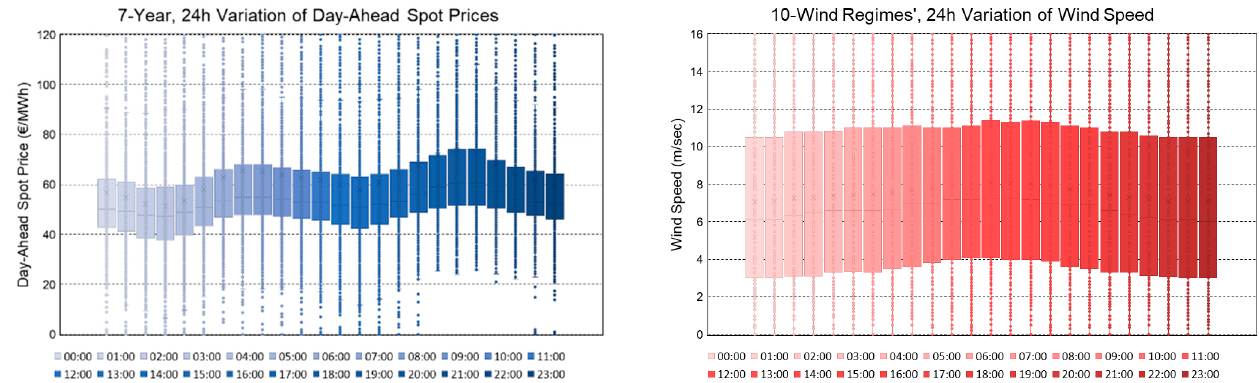
Figure 3. 24 h variation of electricity prices (temporal, capped at 120 €/MWh) and wind speed (spatial, capped at 16 m/s).